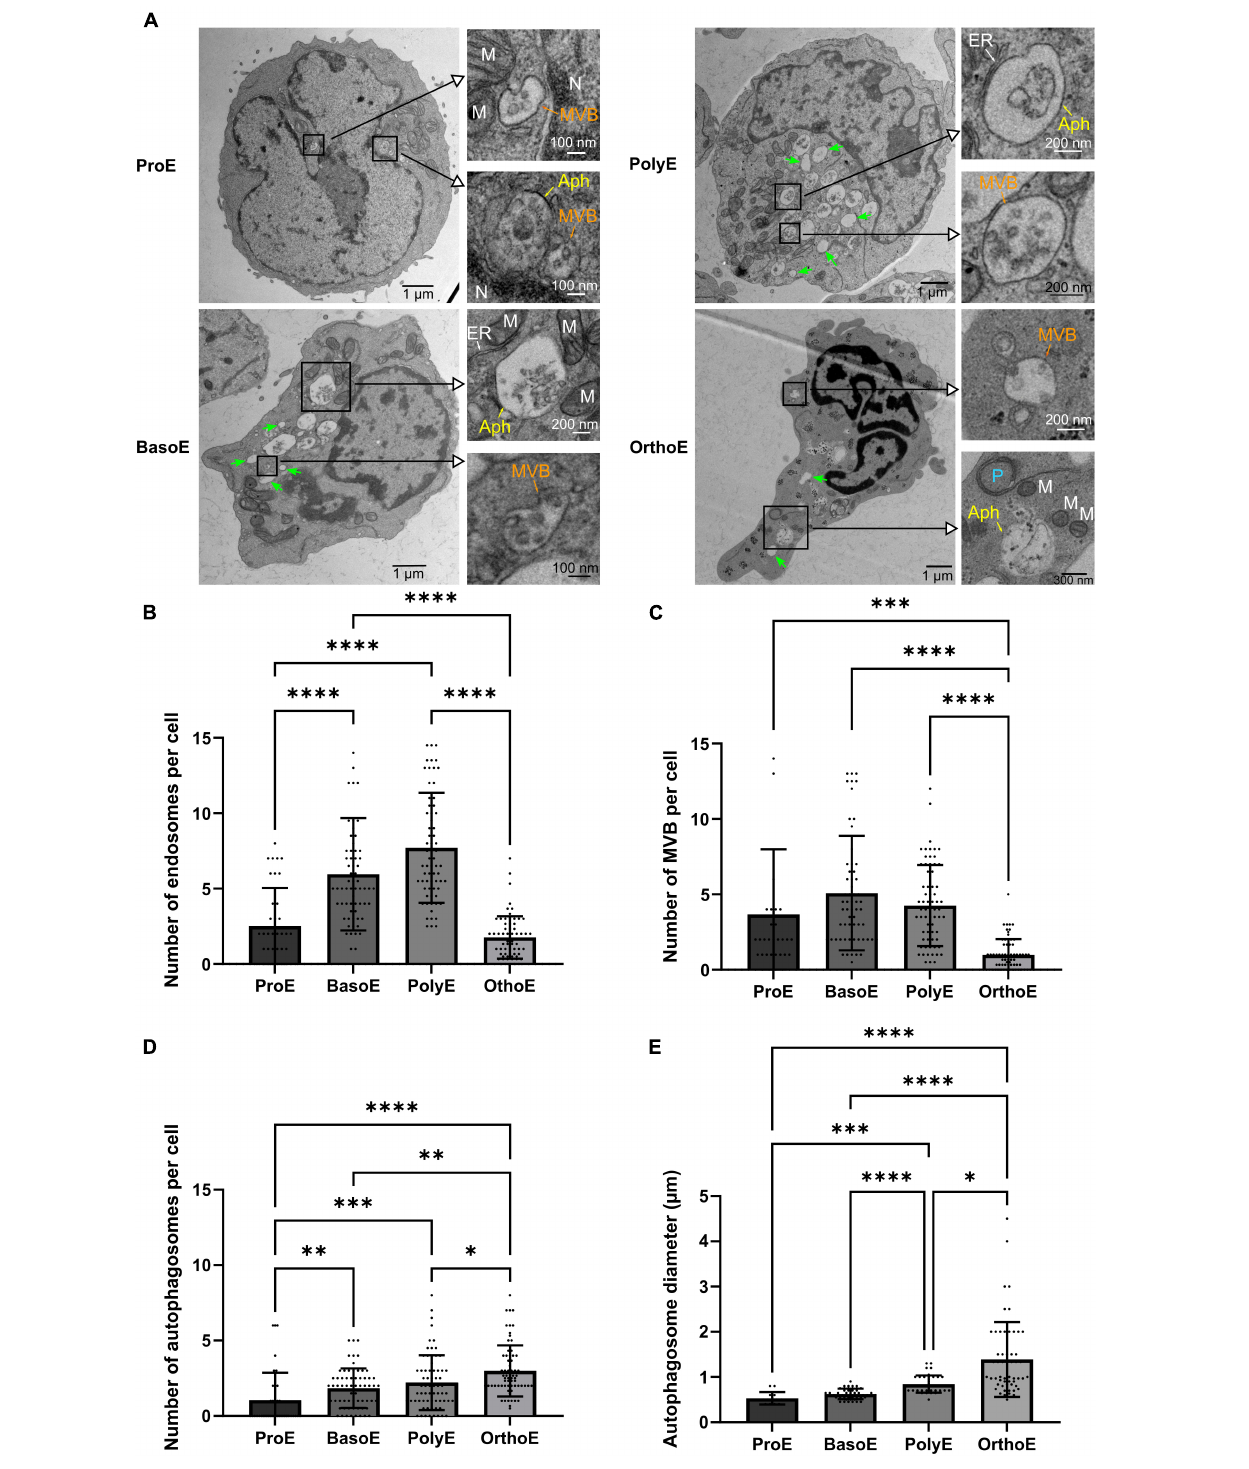
FIGURE 5 | Characterization of the endosomal and autophagic pathway during erythroid differentiation. (A) Representative images of erythroblasts at various stages with insets on intracellular vesicles. Green arrow: endosomes, MVB, multivesicular body; Aph, autophagosome; P, phagophore; M, mitochondria; N, nucleus; ER, endoplasmic reticulum. (B–D) Quantification of endosomes (B) , multivesicular bodies (C) , and autophagic vesicles (D) in each differentiation stage. (E) Measure of the diameter of the autophagic structures over the different erythroid differentiation stages. Kruskal–Wallis analysis on at least 20 images for the three replicates. * p < 0.05; ** p < 0.01; *** p < 0.005, **** p <